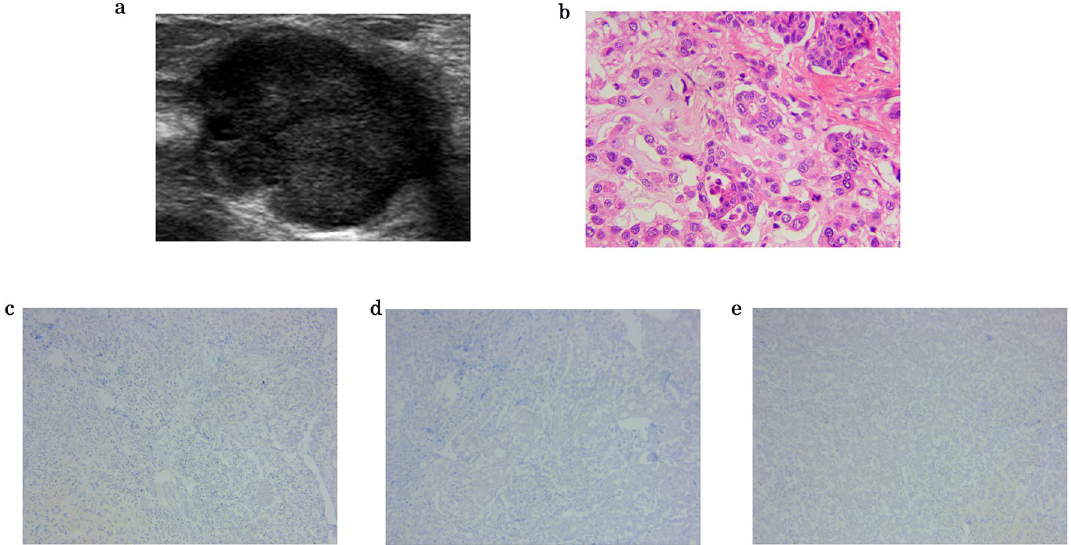
Figure 2. Images in a 52-year-old woman with triple-negative breast cancer (TNBC). ( a ) Grey-scale US images presenting with an irregular shape mass suspicious for cancer. ( b - e ) Pathological images revealed invasive ductal cancer ( b : HE*400, c : absence of estrogen receptor, d : absence of progesterone receptor, e : absence of human epidermal growth factor receptor 2, G: Ki-67